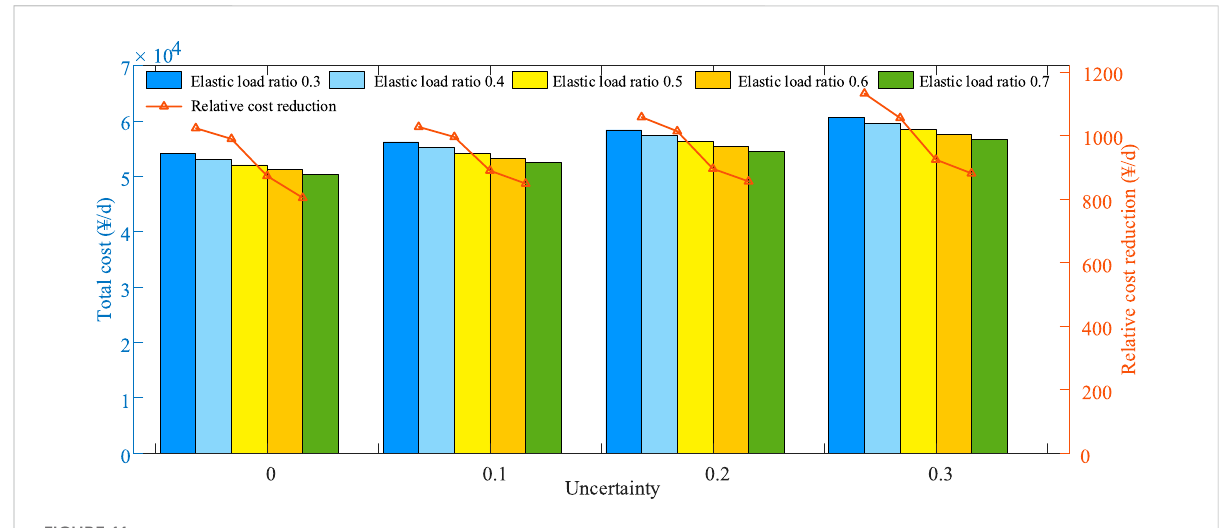
FIGURE 11 The decentralized robust optimal dispatch cost of each agent under different elastic load ratios.